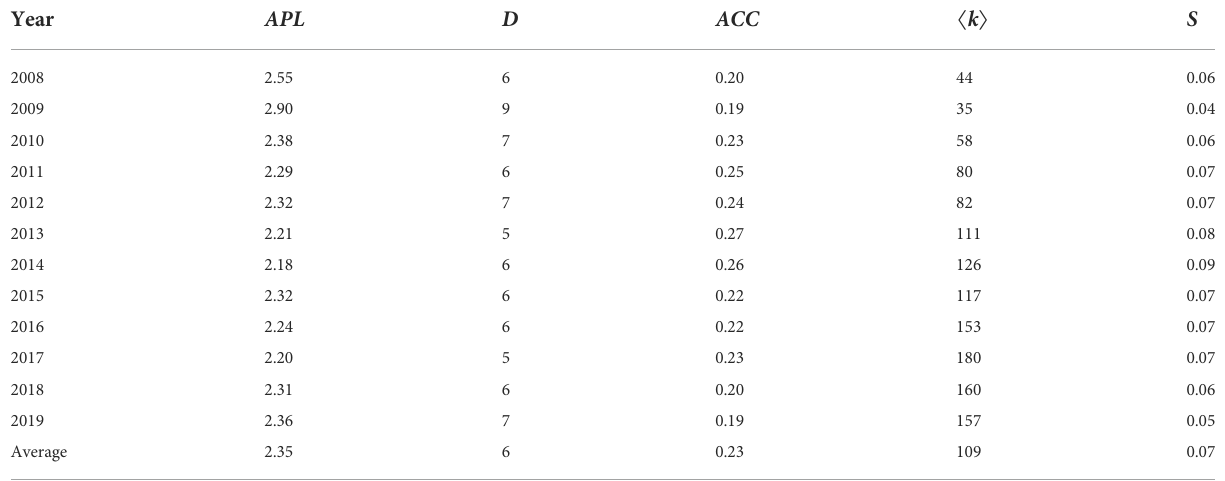
TABLE 1 Network metrics for the China banking